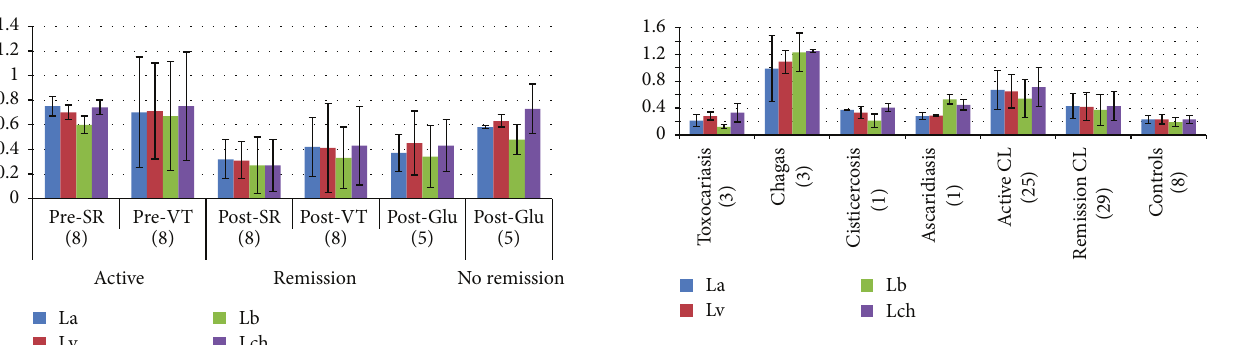
Figure 3: ELISA in patients with cutaneous leishmaniasis and other tropical diseases with complete amastigotes antigens a (patients). La: L(L)amazonensis ; Lv: L(L)venezuelensis ; Lb: L(V)brasiliensis ; Lch: